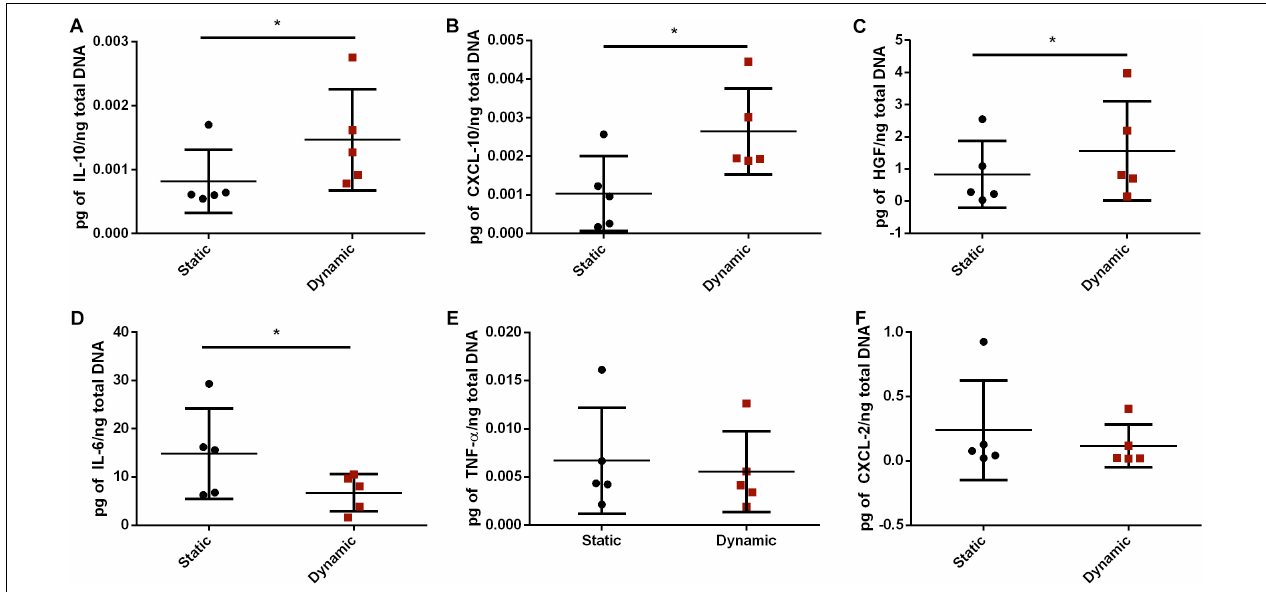
FIGURE 3 | Dynamic culture within the perfusion bioreactor altered the paracrine factor expression profile of the human ASCs cultured on the DAT scaffolds for 14 days. Expression of (A) IL-10, (B) CXCL-10, (C) HGF, (D) IL-6, (E) TNF- α , and (F) CXCL-2 as measured by Human Magnetic Luminex R (cid:13) Assay normalized to total dsDNA content. * p <